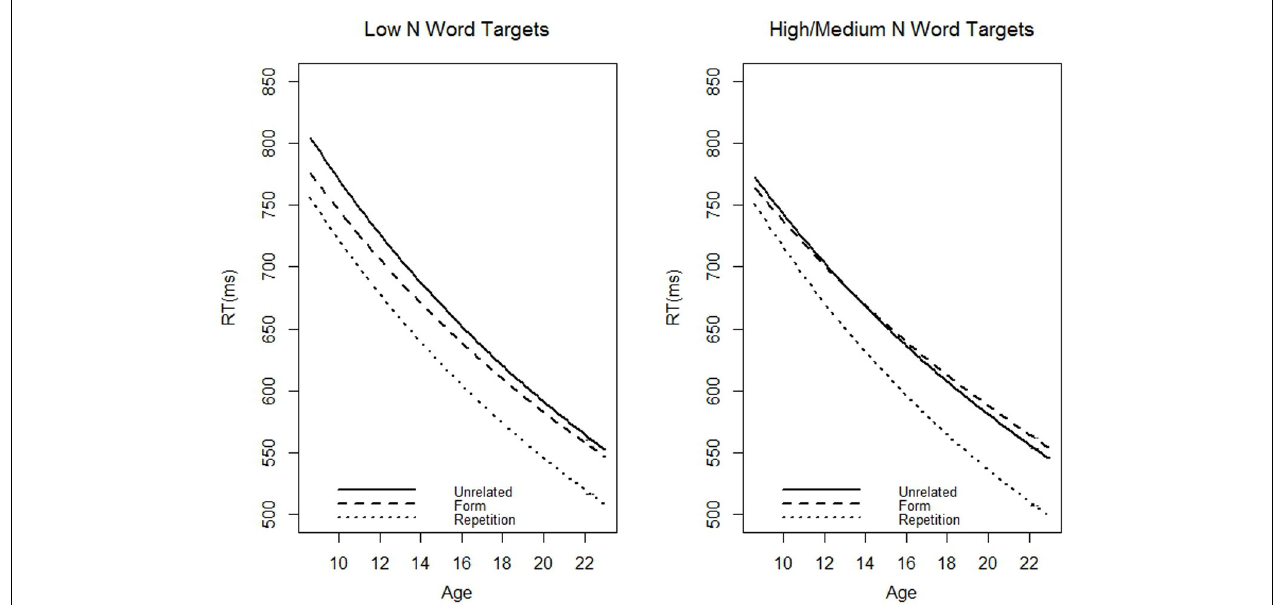
FIGURE 2 | The predicted (based on our models) average reaction time to targets preceded by the three different prime types as a function of age (in years). The trim method was used to clean outliers. This model used